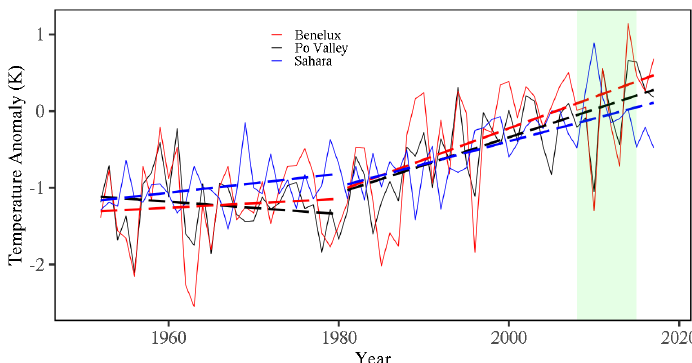
Figure 2. Time-series series of air temperature anomalies calculated over 2007–2016 period (green area). The dataset is freely available at Climate Research Unit